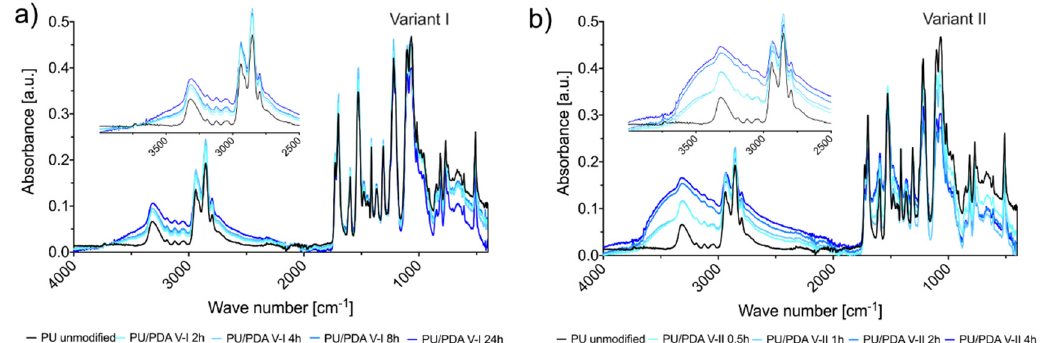
Figure 4. Fourier-transform infrared spectroscopy with attenuated total reflection (FTIR-ATR) spectra of nanofibrous materials in function of modification time in ( a ) variant I, and ( b ) variant II. Inserts enlarge the wave number range from 2500 to 4000 cm − 1 .